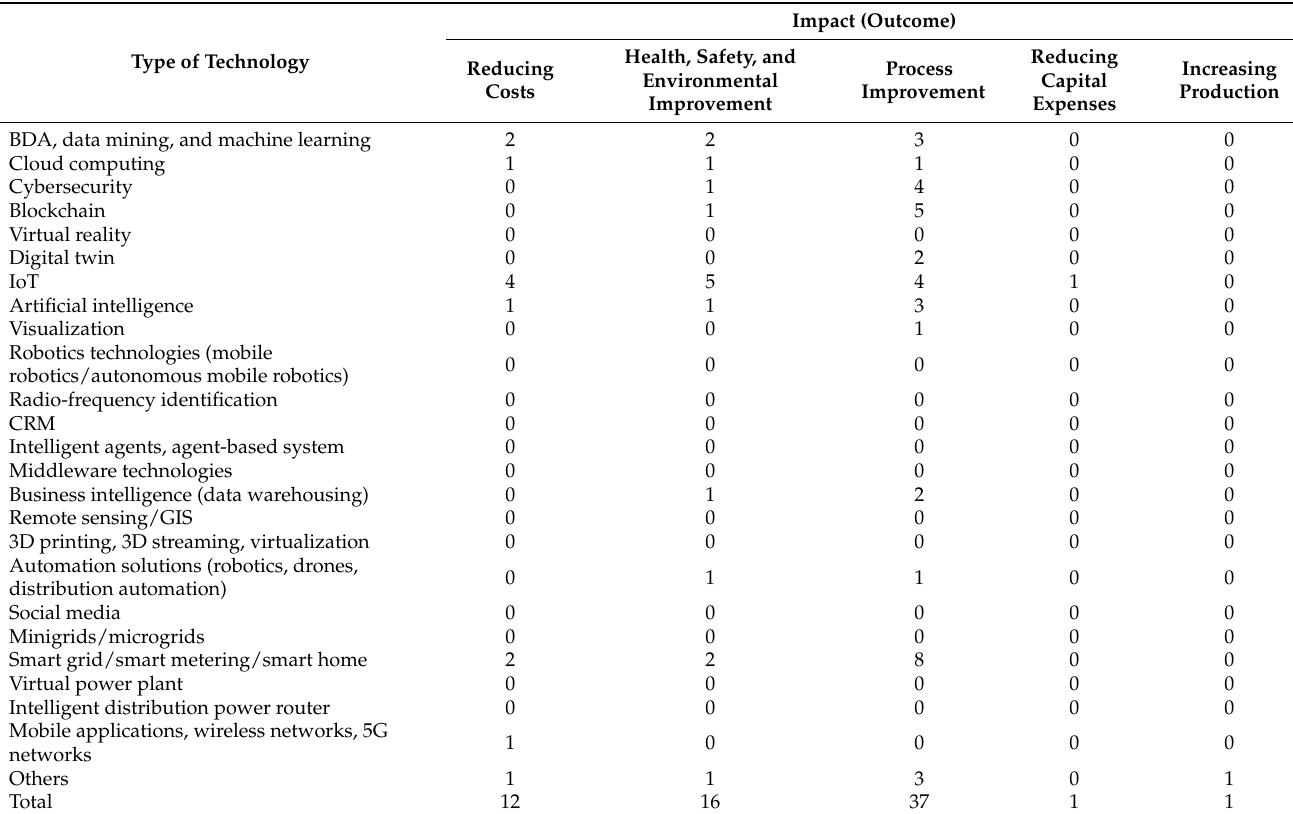
Table 12. The impact of each type of technology in the energy field 1